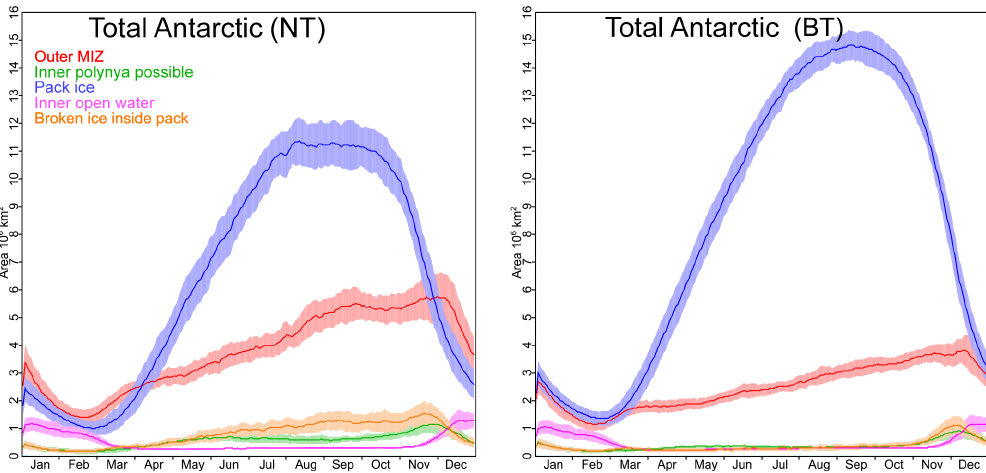
Figure 5. Long-term (1979–2013) and standard deviation (shading) of the seasonal cycle in total Antarctic extent of the consolidated pack ice, the outer marginal ice zone, polynyas, open pack ice (or broken ice within the pack ice), and inner open water. There are essentially no scattered ice floes outside of the MIZ. NASA Team results are shown on the left and the Bootstrap on the right.